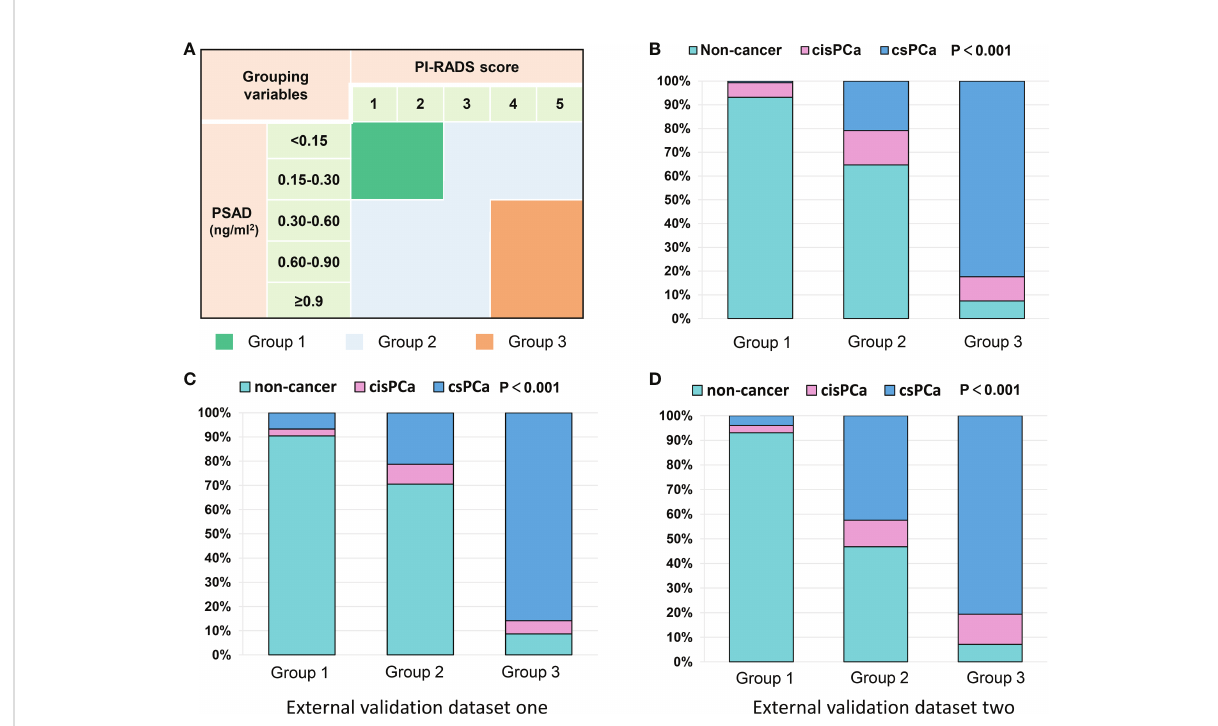
FIGURE 3 Grouping scheme of patients and frequency distribution in each group: (A) grouping scheme of patients by PI-RADS score and PSAD subgroups; (B) frequency distribution of the patients in different groups; (C, D) frequency distribution histograms of two external